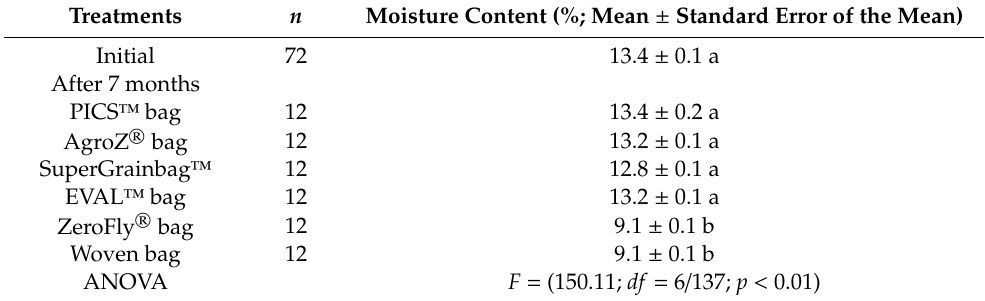
Table 3. Moisture level of naturally infested maize stored in six types of storage bags for seven months in Parakou,